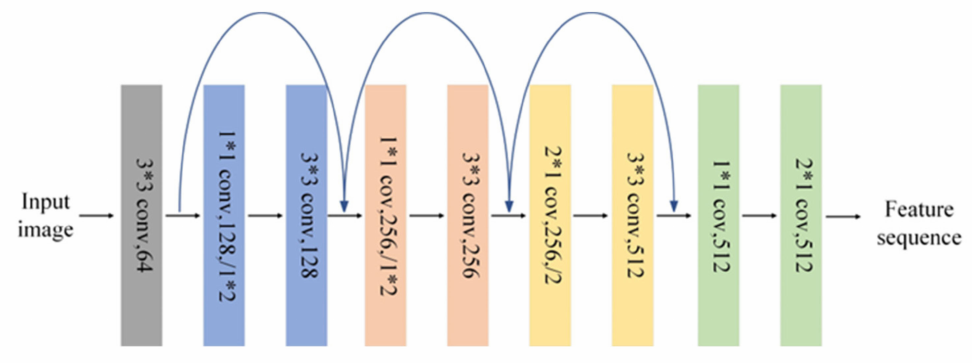
Figure 5. The network architecture of the novel short-memory sequence-based model.